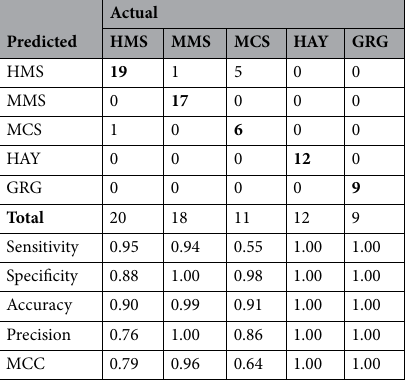
Regression coefficients of the forages